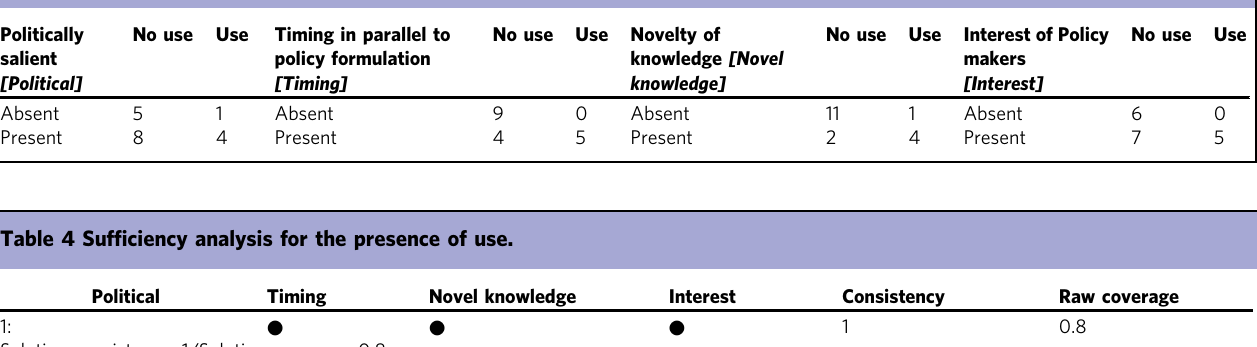
Table 3 Analysis of necessity.